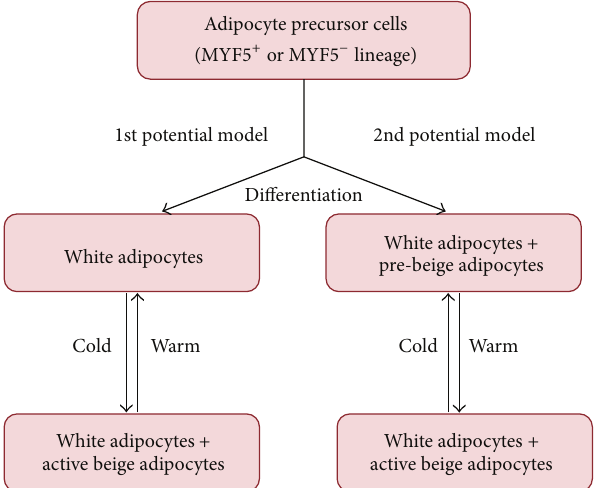
Figure 2: Two potential models of how WAT can be transformed into beige adipocytes [23, 25,